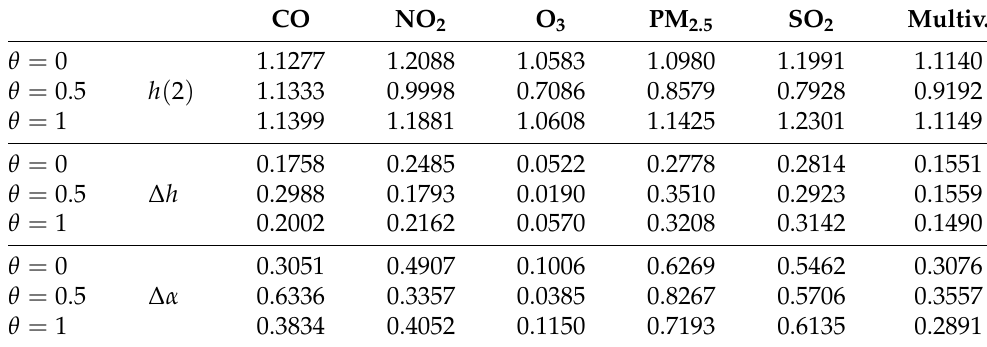
Table 5. The scaling exponent h ( 2 ) , multifractality degrees ∆ h , and ∆ α : seasonally adjusted series.